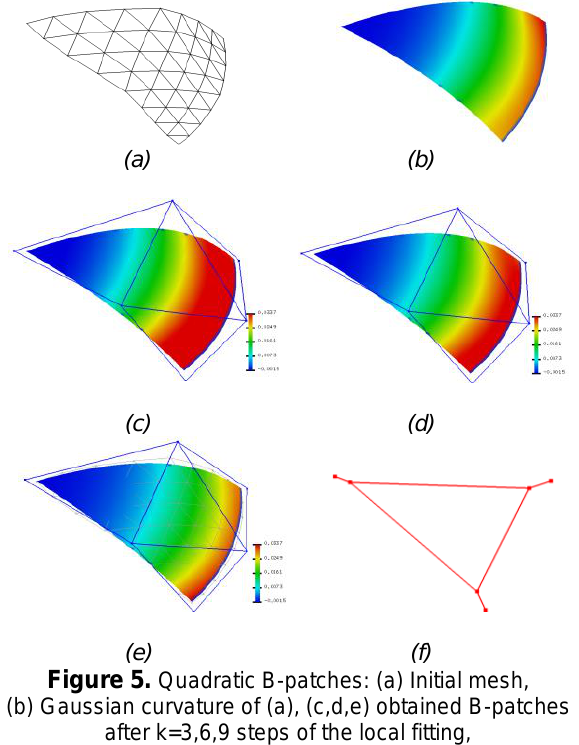
Figure 5. Quadratic B-patches: (a) Initial mesh, (b) Gaussian curvature of (a), (c,d,e) obtained B-patches after k=3,6,9 steps of the local fitting, (f) parametric domain and knotclouds of (e).